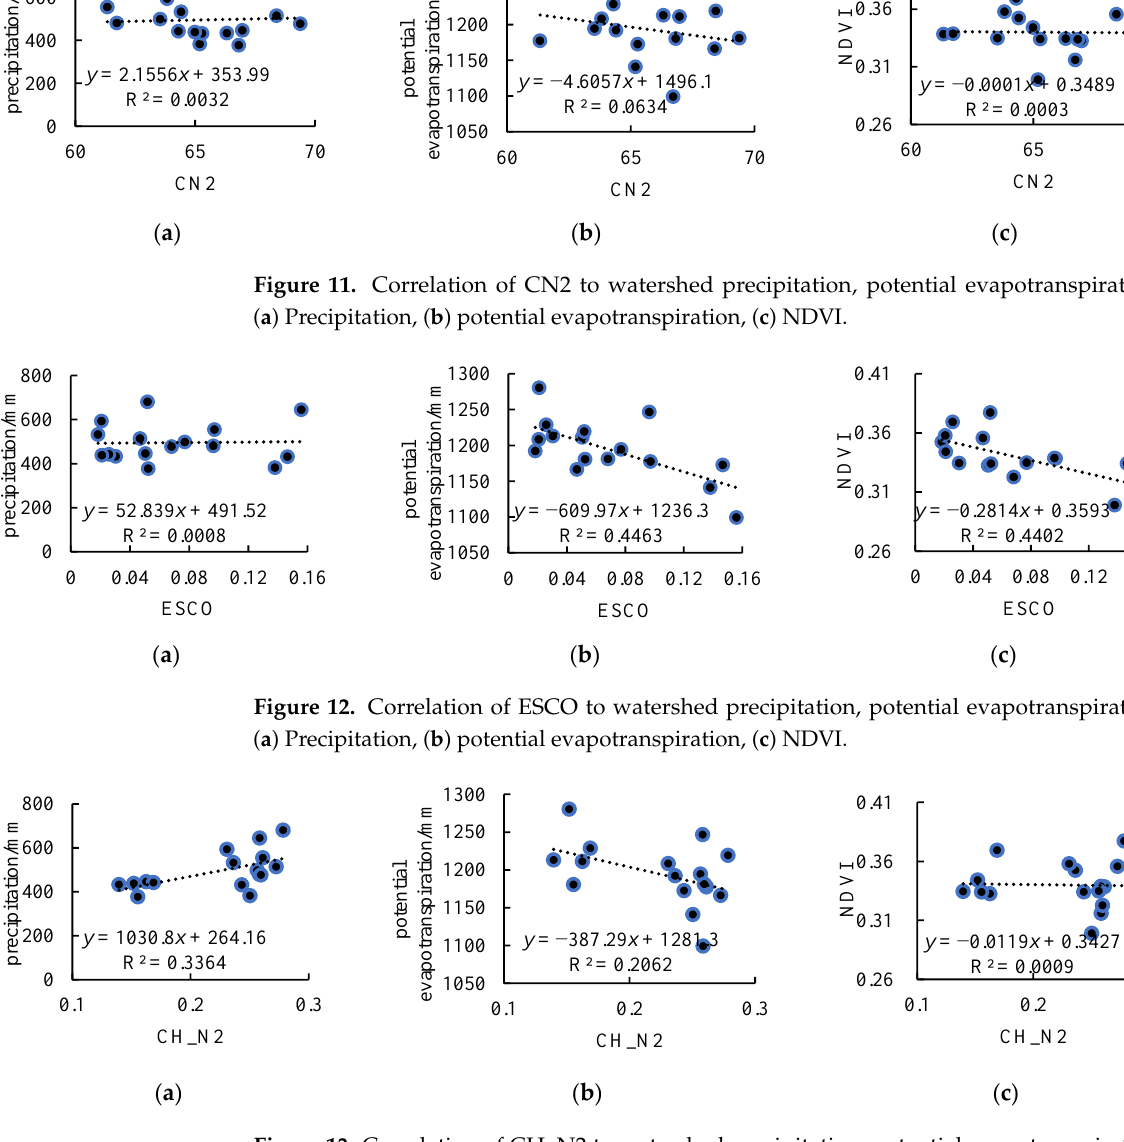
Figure 13. Correlation of CH_N2 to watershed precipitation, potential evapotranspiration, NDVI. ( a ) Precipitation, ( b ) potential evapotranspiration, ( c )